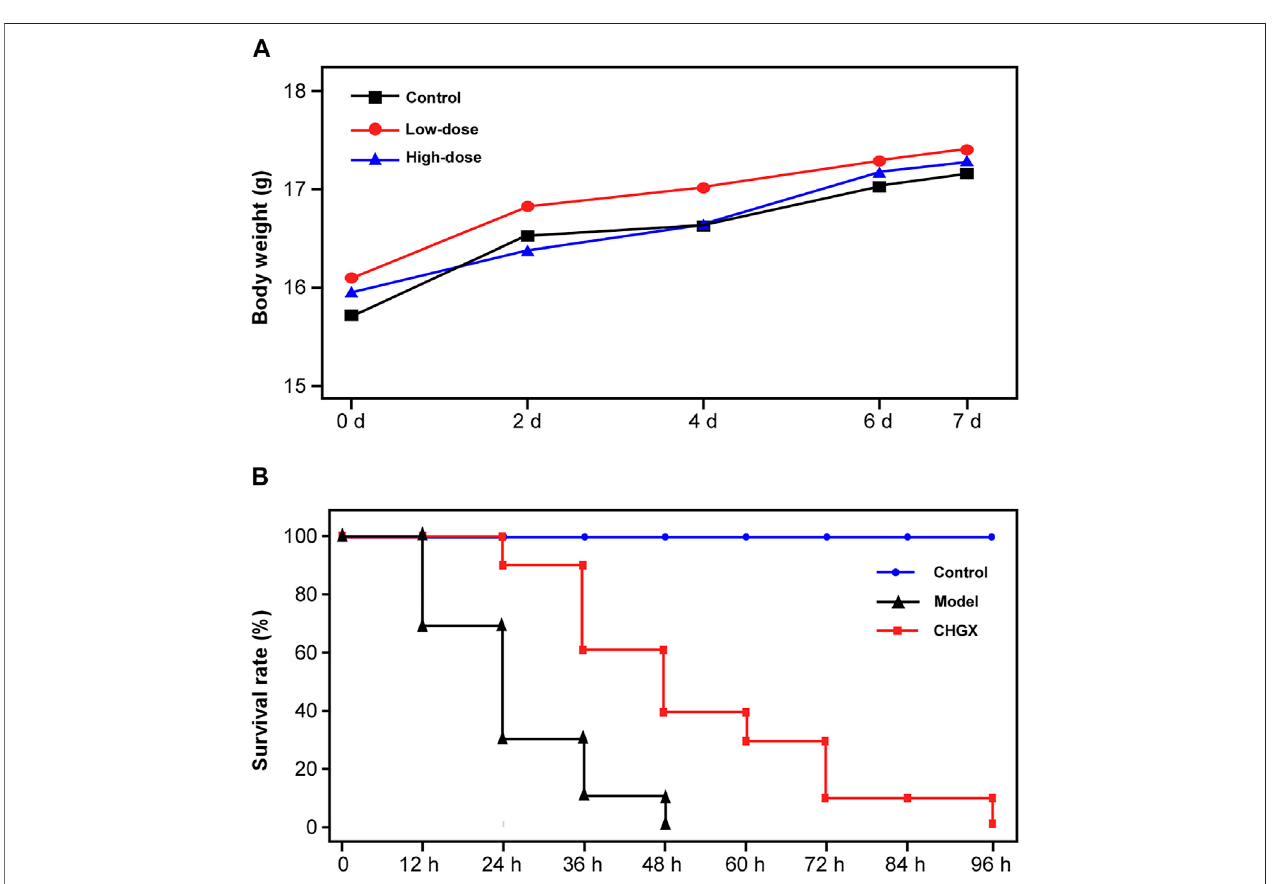
FIGURE10| The invivo toxicityassayandantifungalef fi cacyofCHGXinmurinemodel. (A) EffectofdifferentdoseofCHGXonthebodyweightinmice.Mice were randomly divided into control groups, low-dose (6.5 g/kg/day) group and high-dose (13 g/kg/day) group, fi ve mice were used in each group. During the 7 days of treatment, the body weight of each mouse was recorded, and the average body weight was calculated and presented. (B) Kaplan – Meier curves for the survival rate of candidiasis mice. Mice in model and CHGX groups were intravenously injected with 2 × 10 6 cells of SC5314 in 200 μ l PBS. The CHGX group were orally administeredwith6.5 g/kg/dayCHGXwater-decoctionfor7 days,andthecontrolandmodelgroupsweretreatedwiththesolvent.Themortalityofmicewasmonitored and recorded every 12 h during